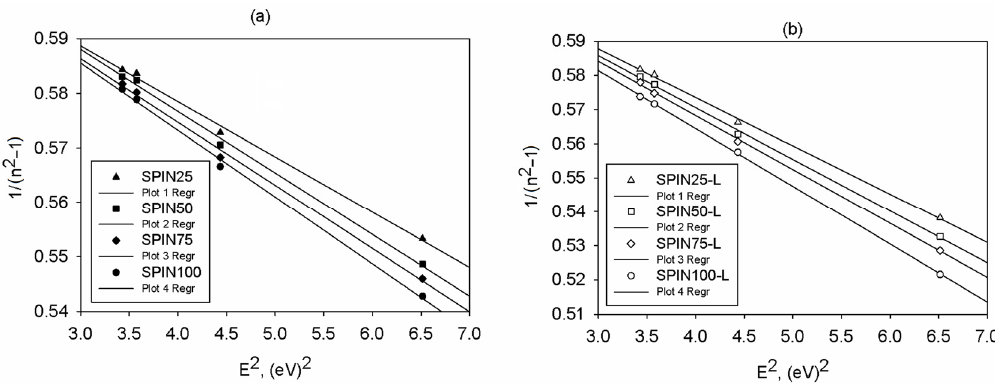
Figure 10. (n 2 − 1) − 1 vs. E 2 plots of ( a ) non-irradiated and ( b ) laser-exposed PI-based supramolecular systems.